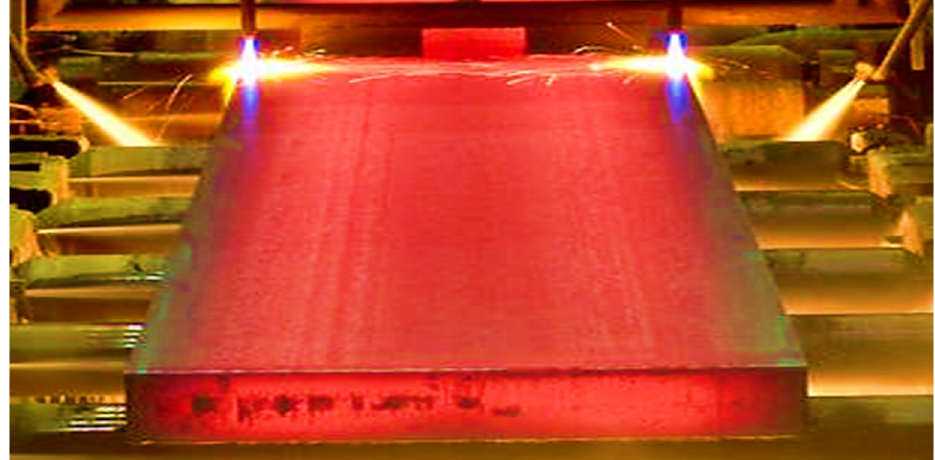
Figure 6. Desired product steel slab material.